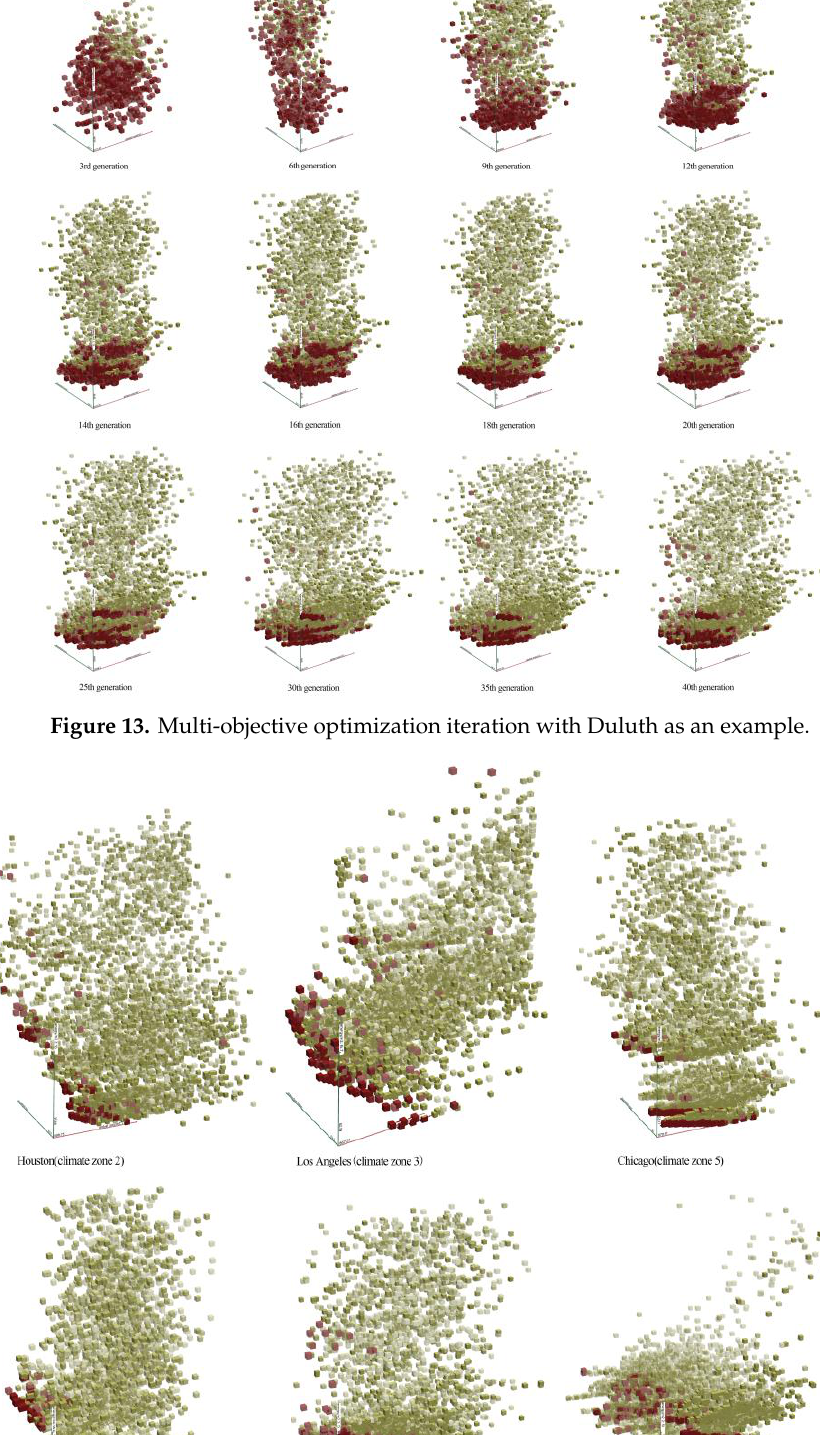
Figure 15. Building energy demand (BED, vertical axis) and global cost (GC, horizontal axis) Pareto frontier in typical American cities.